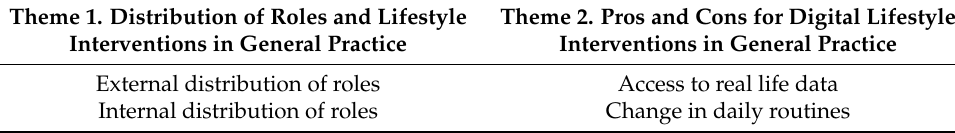
Table 3. Identified themes and associated subthemes in relation to attitudes and behaviour towards digital lifestyle interventions in general practice. Theme 1. Distribution of Roles and